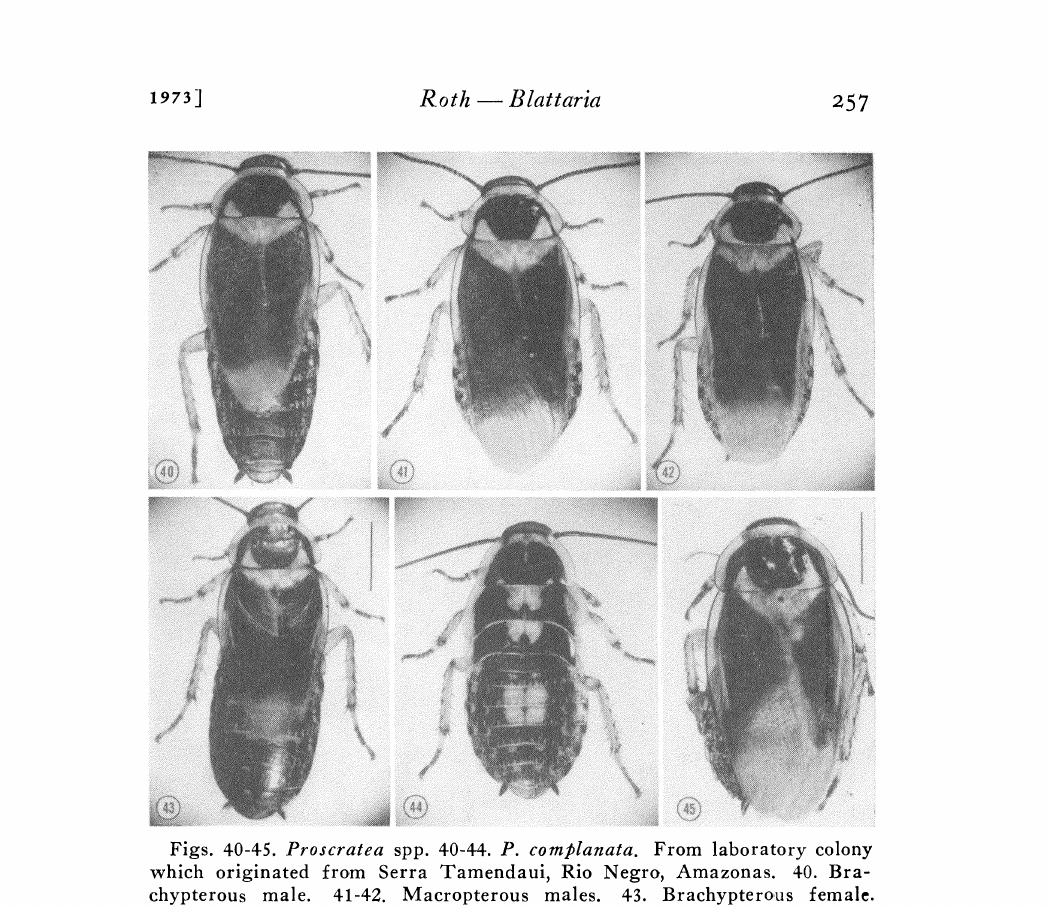
Figs. 40-45. Proscratea spp. 40-44. P. comI)lanata. From laboratory colony , which originated from Serra Tamendaui, Rio Negro, Amazonas. 40. Bra- chypterous male. 41-42. Maeropterous males. 43. Brachyptero.us female. Hacienda San Juan, 44. Female nymph. 45. (129 ANSP). P. "I)eruana’" Colonio Peren, Peru, June 23, 1920; Cornell Univ. Exped. (det. Rehn). (scale- mm; scale for figures 40-44 shown in fig.